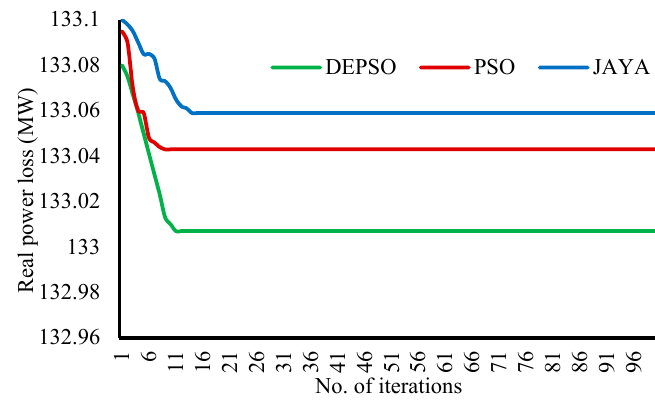
Figure 9. Bus voltage profile for IEEE 118-bus system.